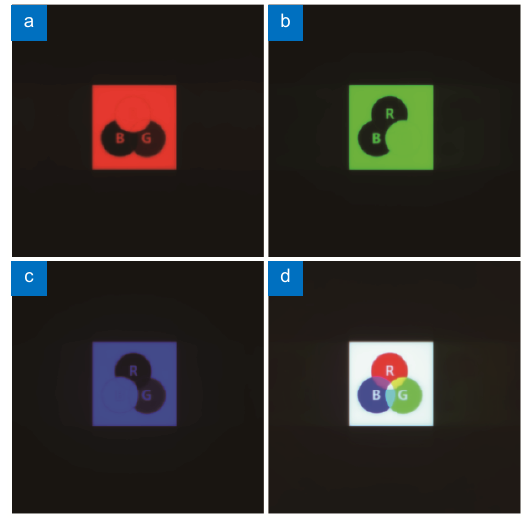
Fig. 5 | ( a–c ) Simulated monochromatic imaging by the metalens for three wavelengths of 473 nm, 532 nm, and 632 nm with incident angles of 0°, -17° and 17°, respectively. ( d ) Synthetic color image by the